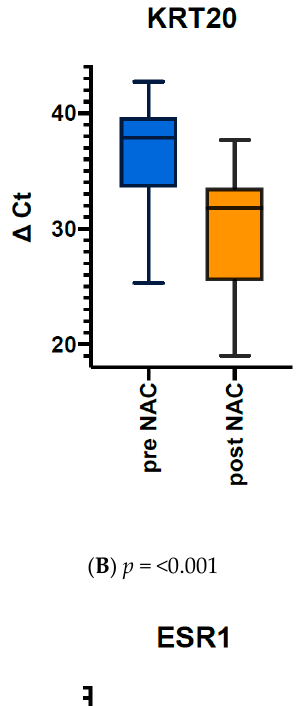
chemotherapy (34.44 vs. 34.49 pre- and post-NAC, respectively).